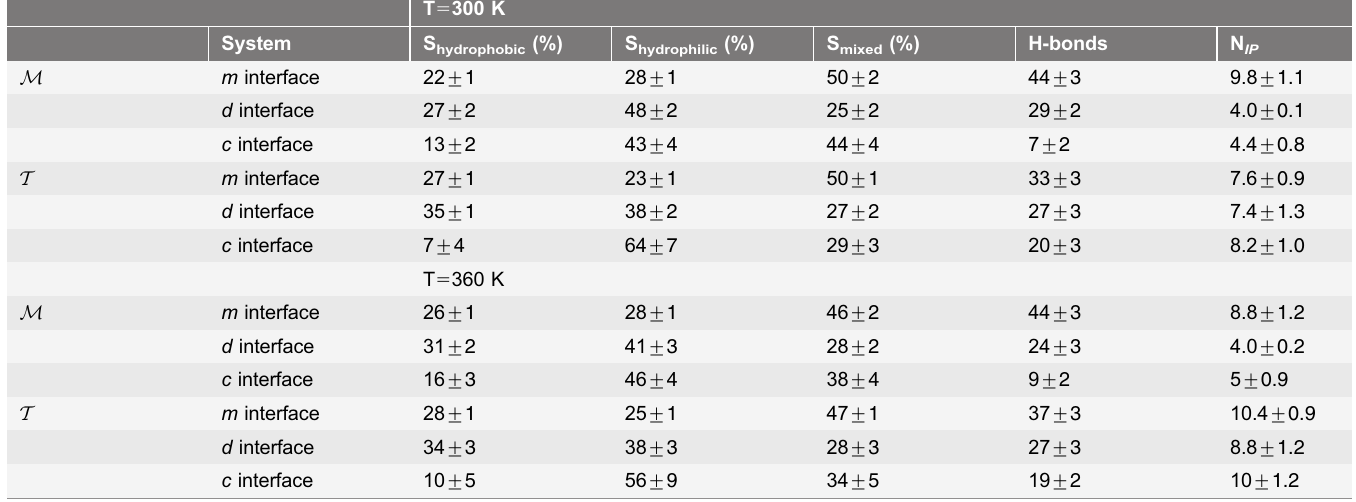
Table 3. Electrostatics and hydrophobicity at the interface.